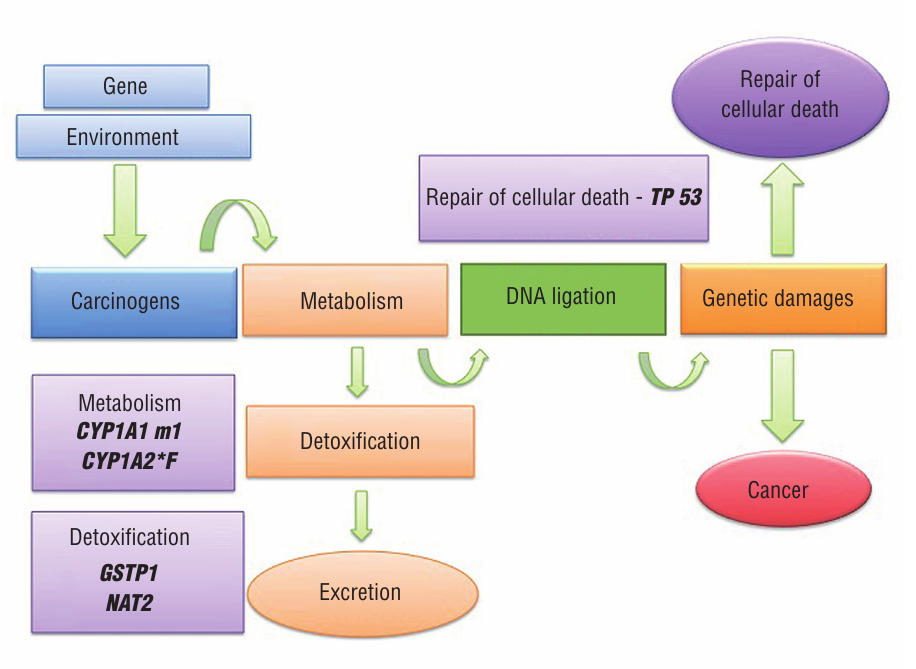
Figure 1 - Mechanism of detoxification and repair of DNA related to TP53 and